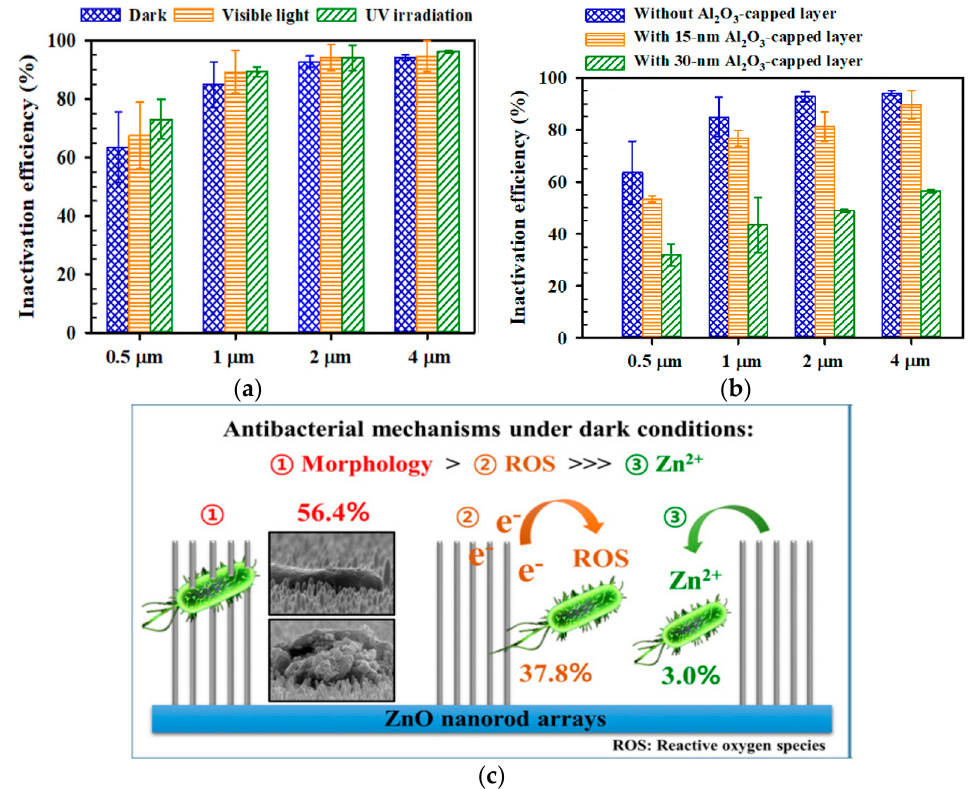
Figure 28. ( a ) Inactivation efficiency of E. coli treated with ZnO nanorod arrays of various lengths (0.5–4 µm) for 30 min under different conditions (dark, visible light, and UV irradiation). ( b ) Inactivation efficiency of E. coli treated with ZnO nanorod arrays of various lengths with different Al 2 O 3 layer thicknesses for 30 min in the dark. The values are the average of triplicate measurements, and error bars denote the standard deviation. ( c ) Bactericidal mechanisms of ZnO nanorod arrays in the dark: membrane rupture due to the nanorod piercing (inset: SEM images) > ROS generation > released Zn 2+ ions. Reproduced from [288] with permission of Elsevier.